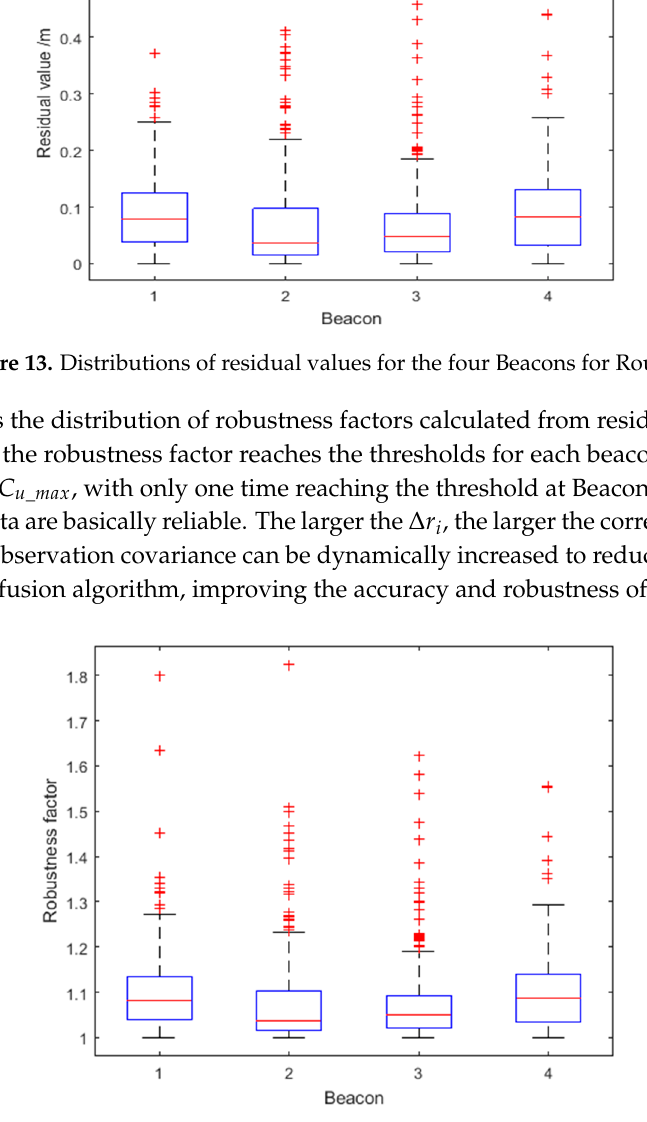
Figure 14. Distributions of robustness factors for the four Beacons for Route 1. Table 3. The number of times the robustness factor reaches the threshold C u _ max .